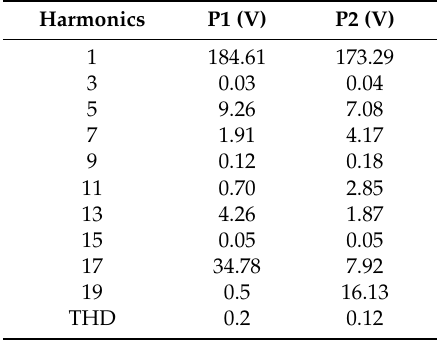
Table 1. FFT results of the induced EMF.